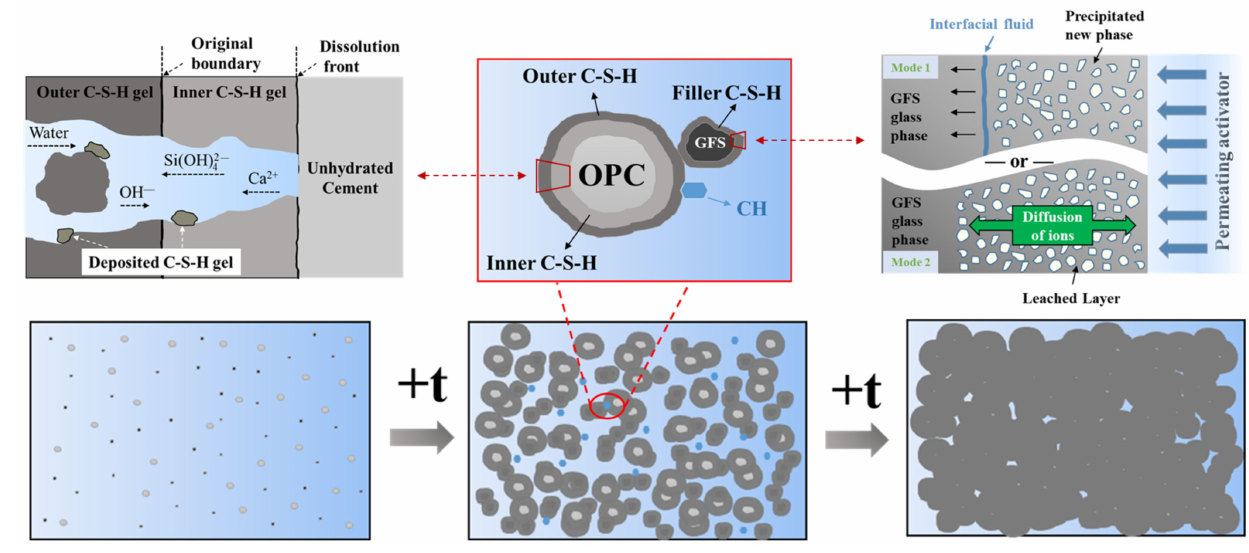
Figure 10. The hydration process